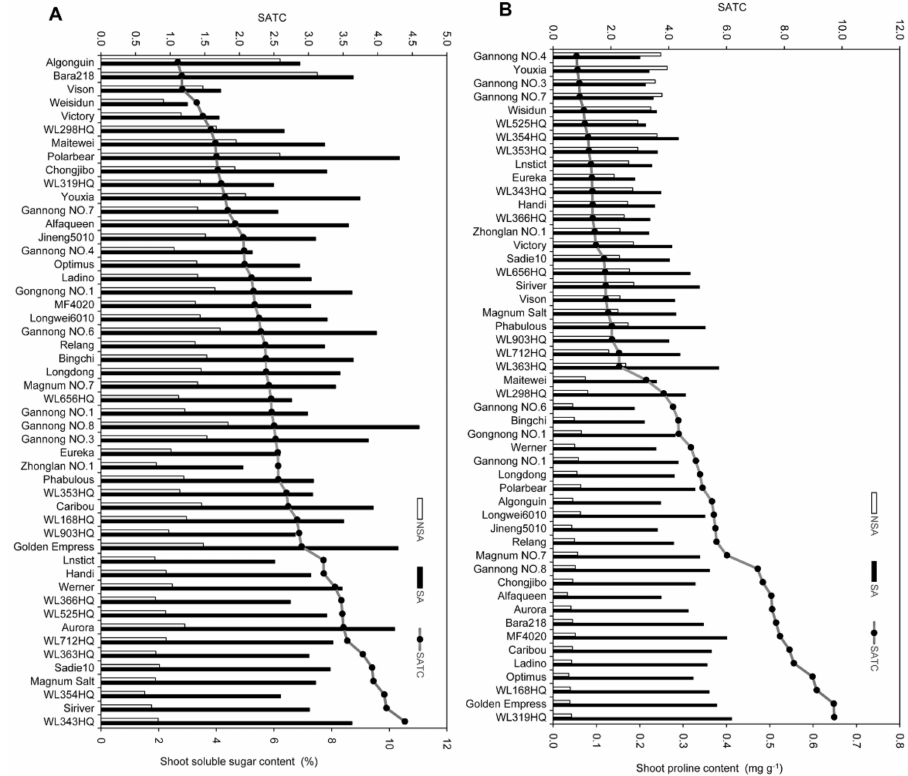
Figure 2. The shoot soluble sugar content (SS) (A) and shoot proline content (PRO) (B) of 50 alfalfa cultivars field-grown in nonsaline-alkaline (NSA) (open bar) soil and saline–alkaline (SA) (solid bar) soils during the seedling stage. The line represents the saline-alkaline-tolerance coe ffi cient (SATC). Values are the means of absolute values, n =